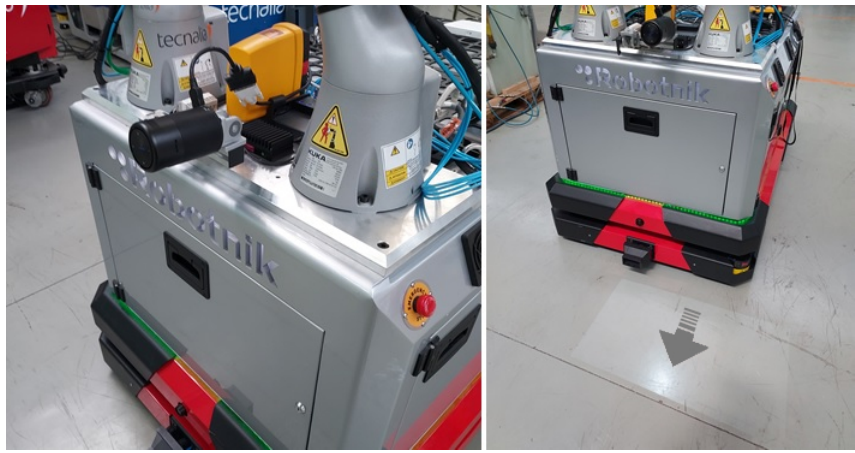
Figure 5. Projector installed on robotic platform to display the direction to the next path pose.